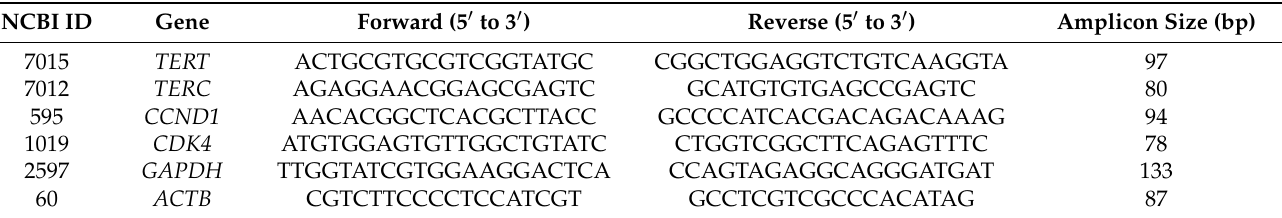
Table 3. Primer sequences used in RT-PCR.